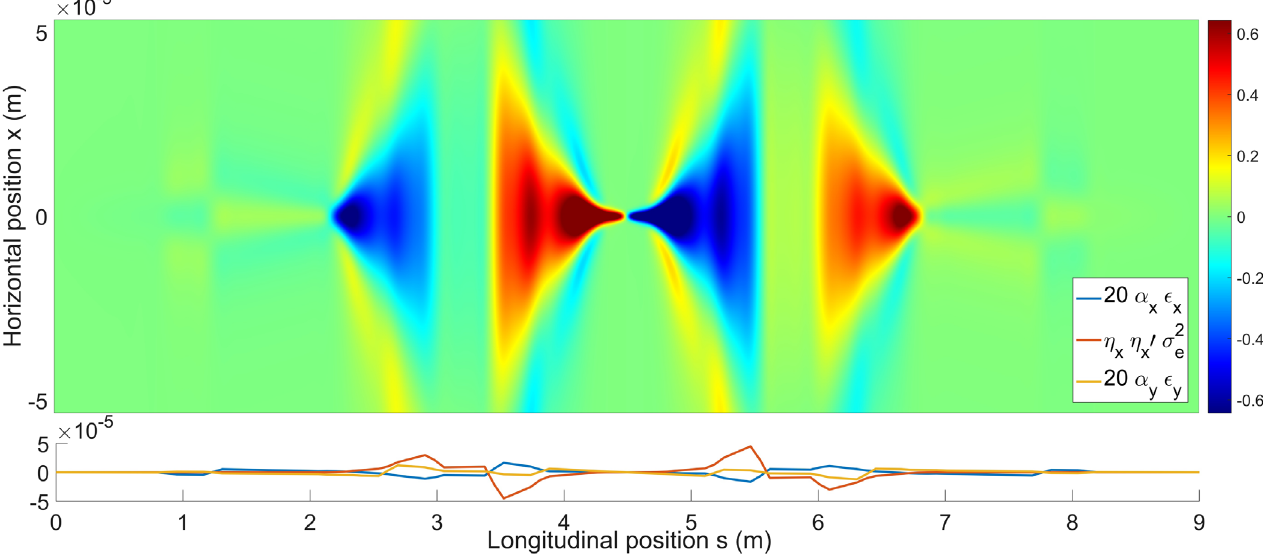
FIG. 2. Top: Color map of the longitudinal kicks Δ v s vs the horizontal position x and the longitudinal position s along half of the ThomX ring for CO þ ions ( A ¼ 28 ). Bottom: 20 α x ϵ x in blue, η x η x 0 σ ϵ 2 in orange and 20 α y ϵ y in yellow vs the longitudinal postion s along half of the ThomX ring. The emittance terms of Eq. (3) have been multiplied by 20 in order to make their variations